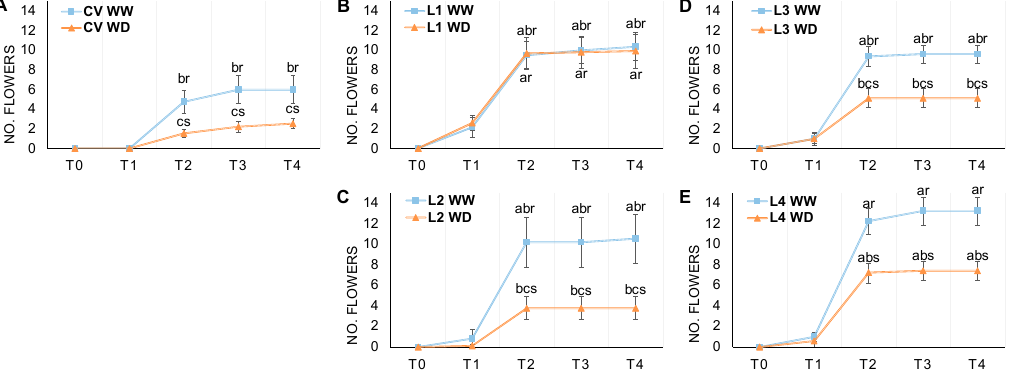
Figure 2. Flowering development (No. flowers) of Portuguese cowpea plants, a commercial variety (CV) ( A ) and four landraces, L1 ( B ), L2 ( C ), L3 ( D ), and L4 ( E ) under well-watered (WW) and water deficit (WD) conditions, at the beginning of treatment (T0) and 5, 7, 9, 10 and 11 weeks after, T1, T2, T3, and T4, respectively. Values represent mean ± SE ( n = 5 to 10). Different letters mean significant differences between varieties (a, b, c) and between treatments for each variety (r, s). The letters (a) and (r) correspond to the highest values. (ANOVA, p < 0.05).